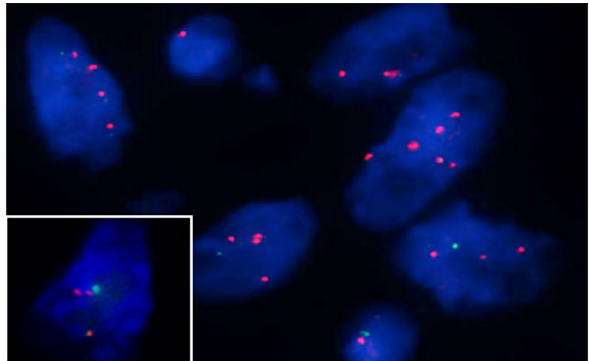
Fig. 3 Chromosome 12p copy number increased in VMT cells by FISH (red